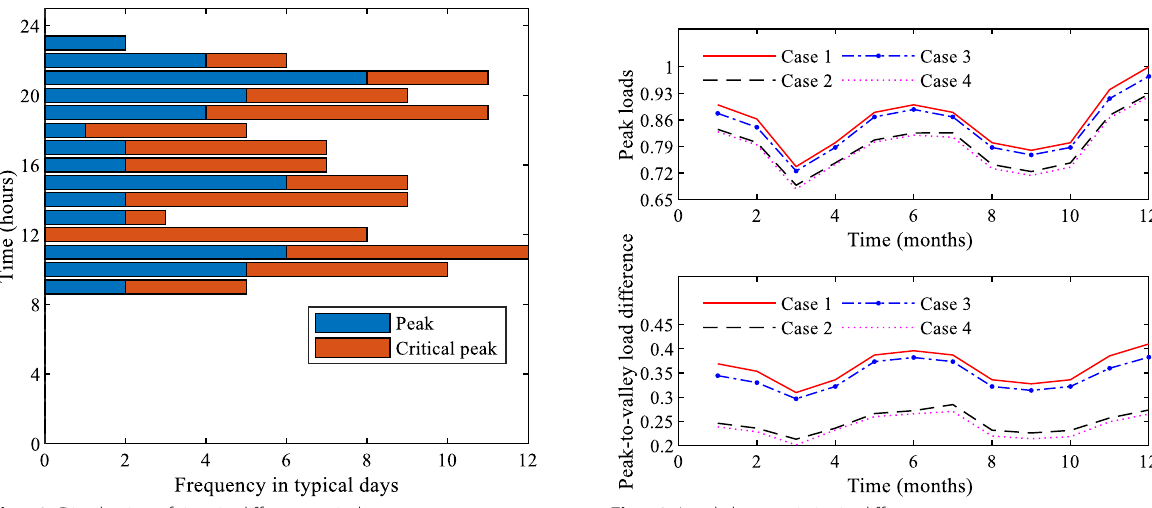
Fig. 12 Load characteristics in different